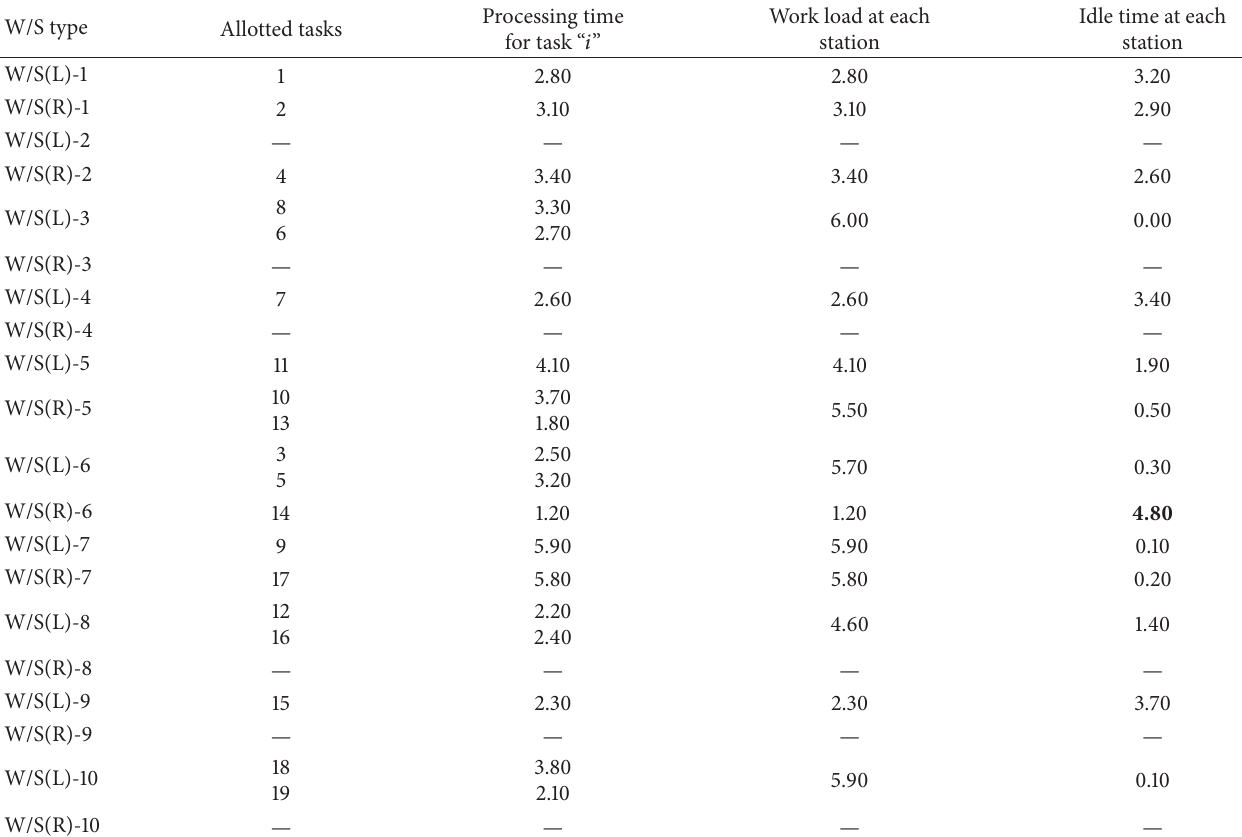
Table 3: Allocation of tasks for Ist assignment of P19 (CT =